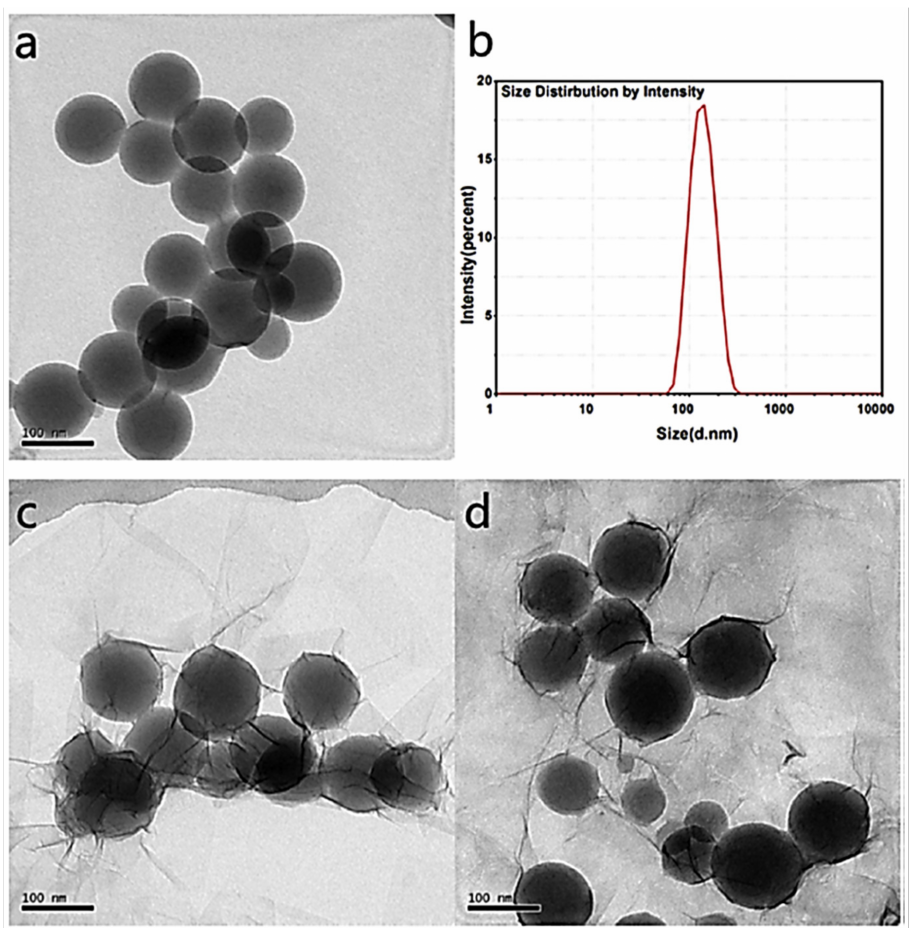
Figure 9. ( a ) Transmission electron microscopy images of polystyrene dispersion; ( b ) size distribution of polystyrene microspheres; ( c ) polystyrene nanocomposite with 1.34 vol.% graphene oxide before in situ reduction, and ( d ) polystyrene/graphene nanocomposite with 1.34 vol.% graphene [80]. Reproduced with permission from